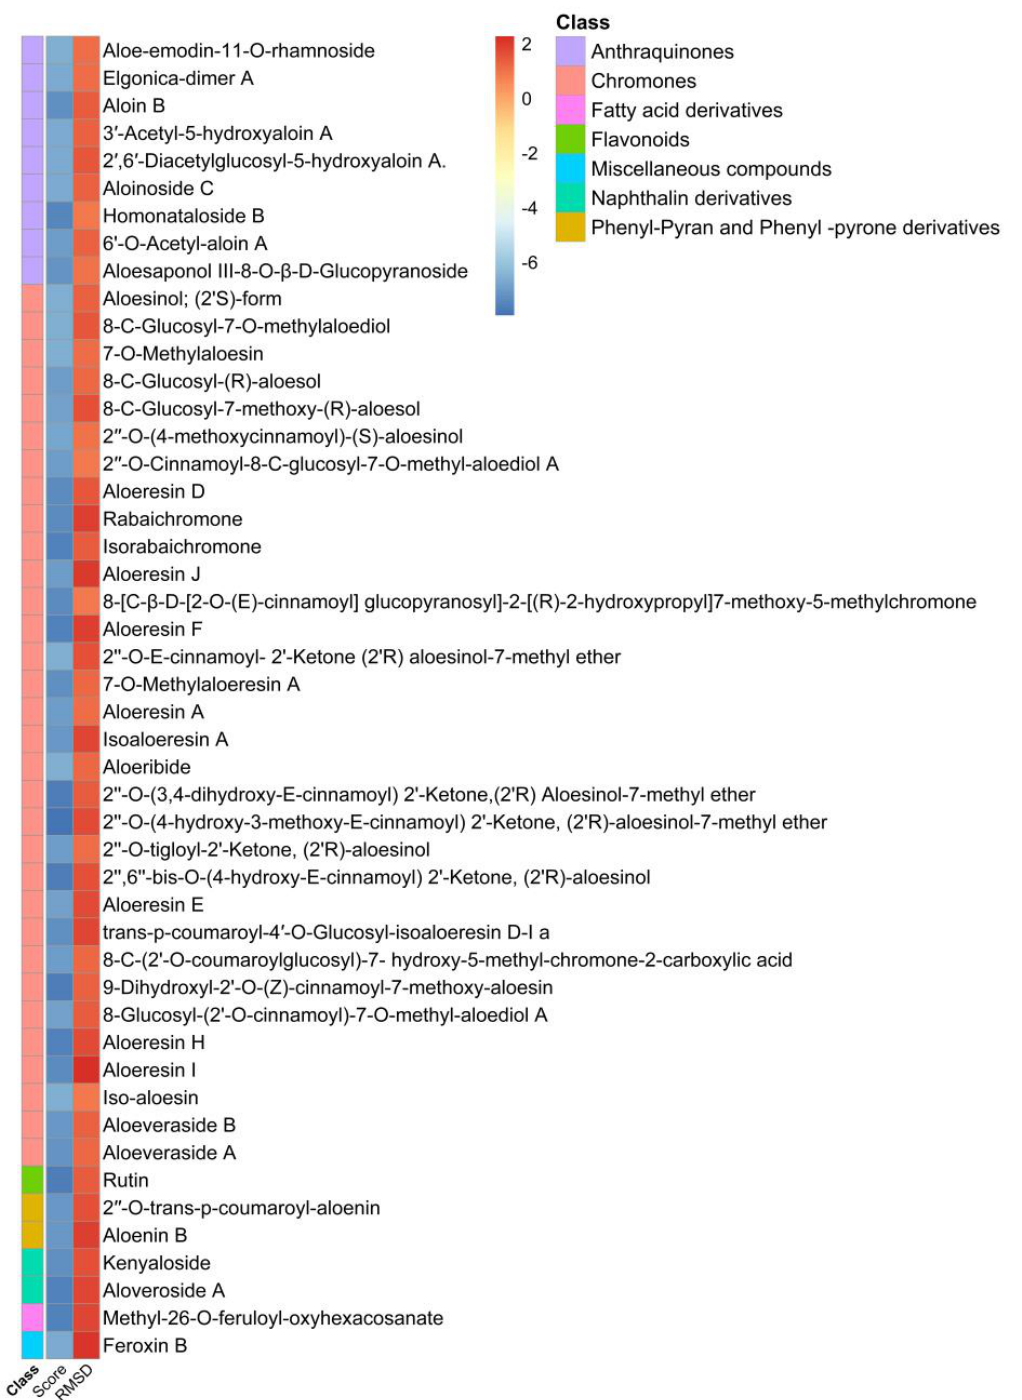
Figure 3. Docking scores and RMSD values of isolated compounds from Aloe genus against SARS-CoV-2 main protease M pro .